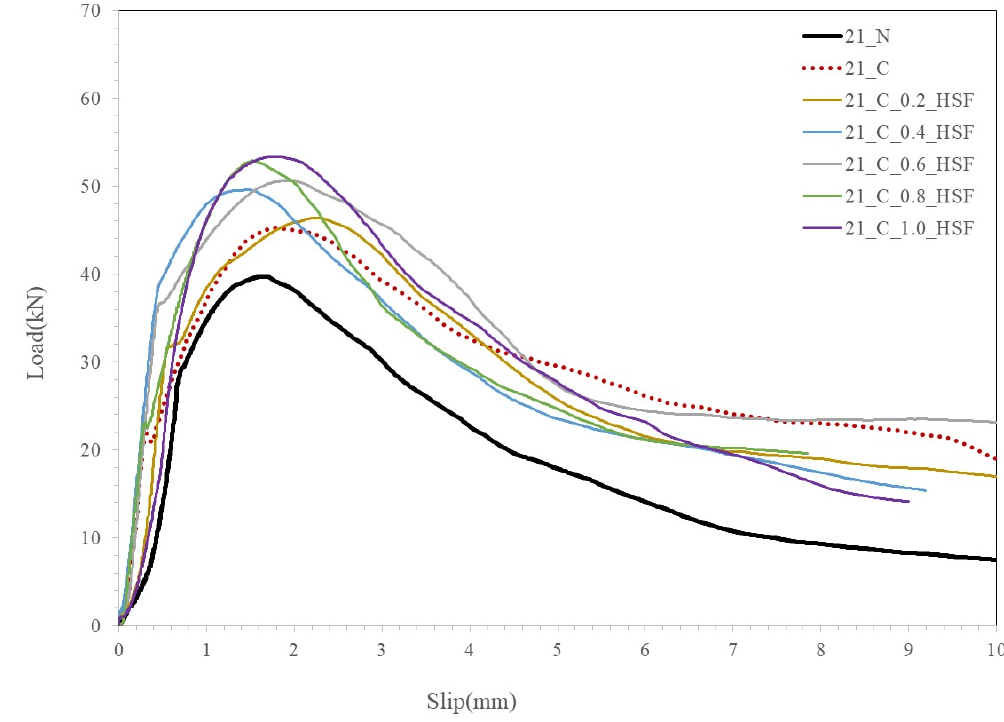
Figure 5. Load–slip curves with hooked-end steel fiber .